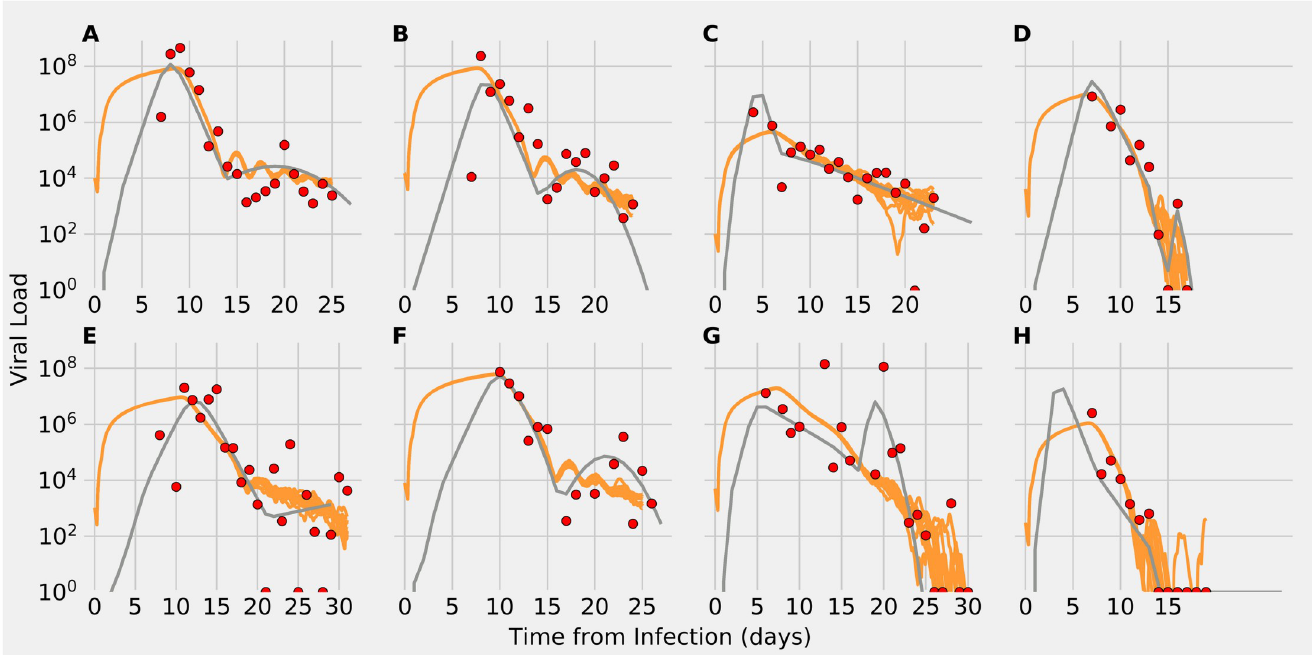
Fig 6. Viral load predictions from SIMCoV simulations (orange) compared to the extended ODE in [12] (gray), and patient data from [36] (red points). For each simulation, 10 random runs are shown.